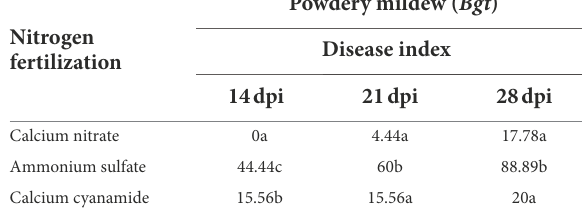
TABLE 1 Disease index of powdery mildew on winter wheat cultivar Emerick treated with different nitrogen forms (calcium nitrate, ammonium sulfate, calcium cyanamide) at 14, 21, 28 days post- infection (dpi).